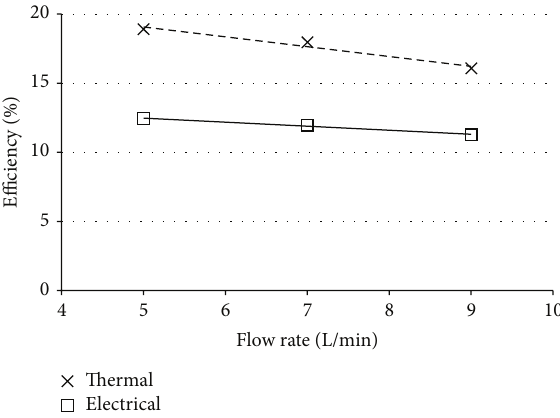
Figure 7: Variation of electrical efficiency with inlet water temper- ature.